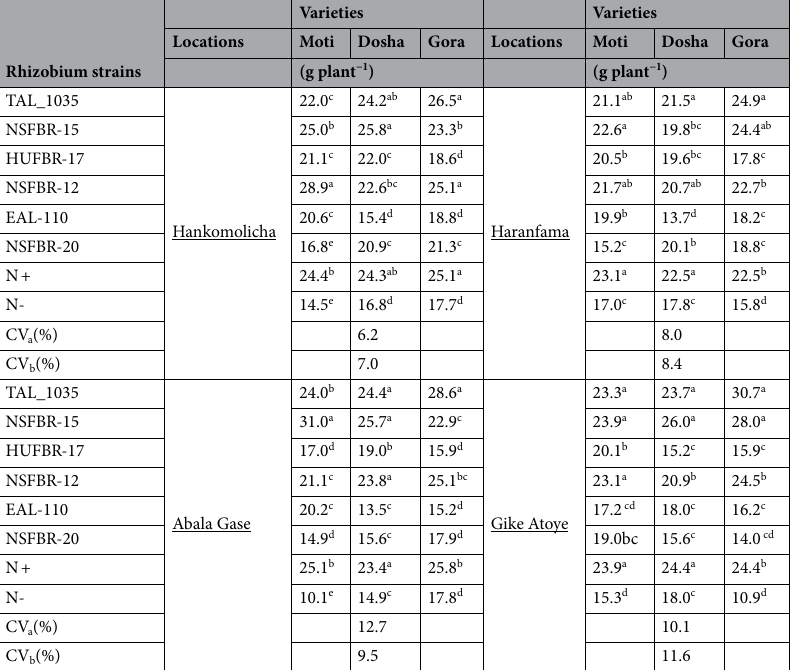
control treatments across the study locations. Inoculation with rhizobium strains significantly (P < 0.01) increased nodule dry weight compared to non-inoculated faba bean plants at all study locations. Analysis of variance across the study locations revealed that, location × rhizobium strain × variety (L × R × V) interaction had significant effect on nodule dry weight plant −1 . Inoculation of NSFBR-15 to variety Dosha and TAL_1035 to variety Gora resulted in the first (463.9 mg/plant) and the second (414.3 mg/plant) highest nodule dry weight plant −1 , respec- tively at Abala Gase (Table 5). Variety Gora inoculated with strain TAL_1035 produced the highest nodule dry weight plant −1 at all experimental sites except at Abala Gase where variety Dosha inoculated with strain NSFBR- 15 produced the highest nodule dry weight plant −1 . The lowest nodule dry weight plant −1 (106.0 mg/plant) was observed with non-inoculated + N control of variety Dosha at Hankomolicha. Location × strain × variety interaction also had significant effect on nodule volume plant −1 . The nodules produced varied in size while nodule volume ranged from 1.3 to 4.7 ml plant −1 (Table 6). Rhizobium strains inoculation significantly improved nodule volume plant −1 over their respective non-inoculated controls at all study locations. Rhizobium strain NSFBR-15 inoculated to faba bean variety Dosha resulted in the highest nod- ule volume plant −1 (4.7 m1/plant) at Abala Gase followed by the same strain inoculated to variety Gora (3.7 ml/ plant) at Gike Atoye while the least nodule volume plant −1 (1.3 ml/plant) was observed with non-inoculated + N control of variety Dosha at Hankomolicha.